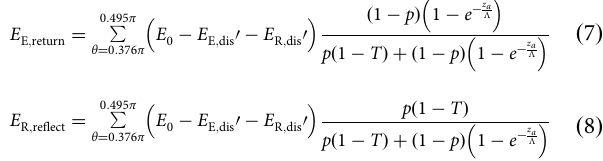
Fig. 2. Within the same TiO 2 -QOF, similar p and z a calculated from the model under the three conditions further con fi rmed they only related to the coating structures rather than to experimental conditions. Based on the average p and z a obtained above, E can be calculated using Eqs. (4) and (5). In addition, to close the energy balance, the returned radiant energy of evanescent waves ( E E,return ) and the re fl ected radiant energy from refraction spots ( E R,re fl ect ) were calculated using Eqs. (7) and (8) (see Supplemen- tary Note 5F for derivation).